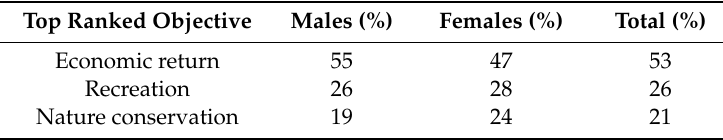
Table 5. Forest owners’ most important management objective ( n = 432).